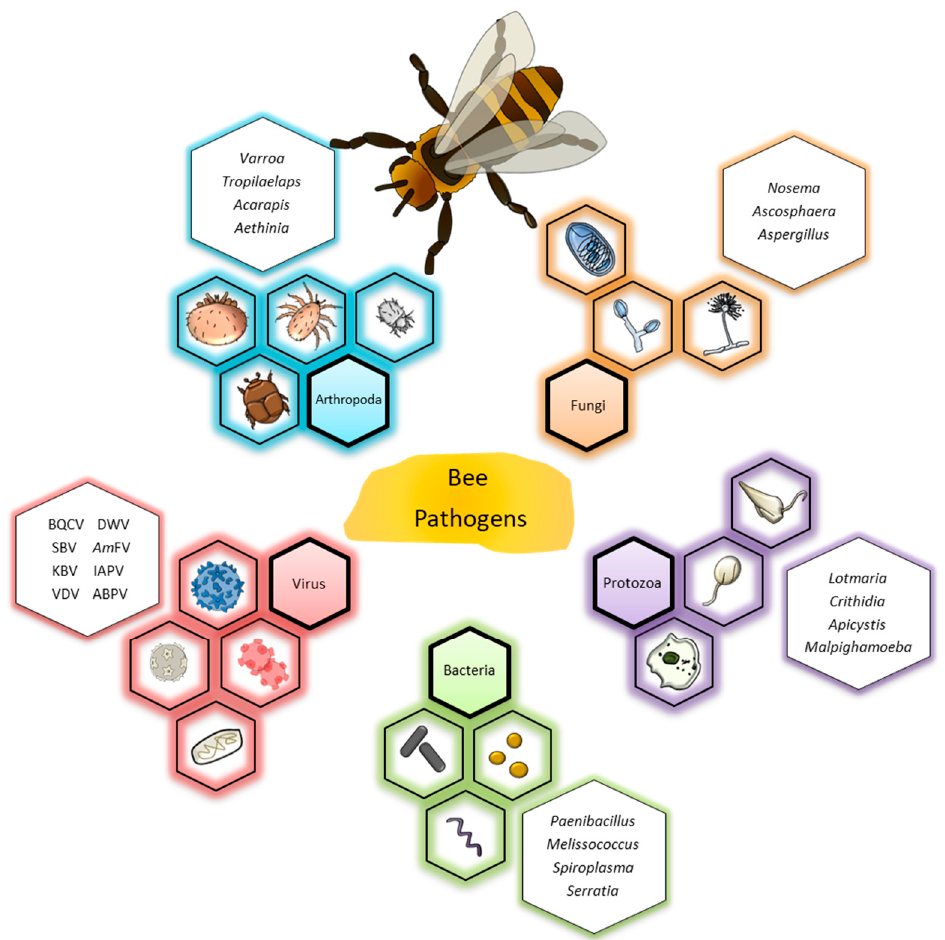
Figure 1. Main bee pathogens. Schematic representation of the main pathogens affecting Apis mellifera , belonging to the Arthropoda, fungi, protozoa, bacteria and virus taxonomic groups.